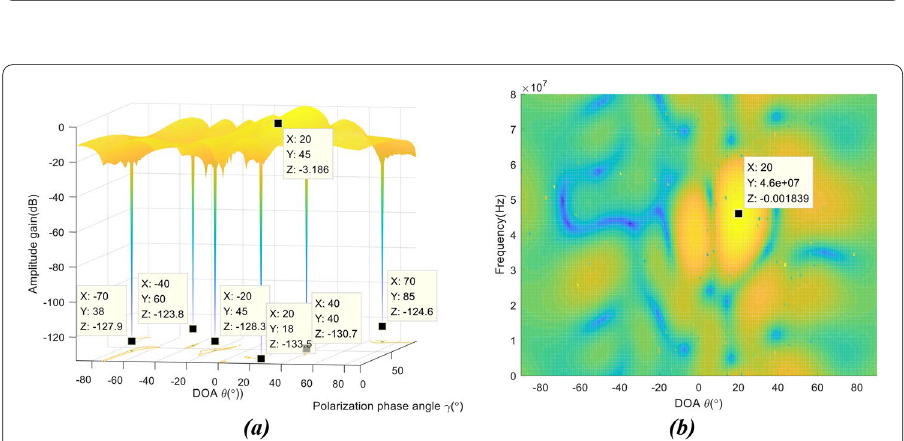
Fig. 6 Three-dimensional beam pattern for the DPSA-STPAP algorithm a space-polarization domain null pattern and b top view of the space–time domain null